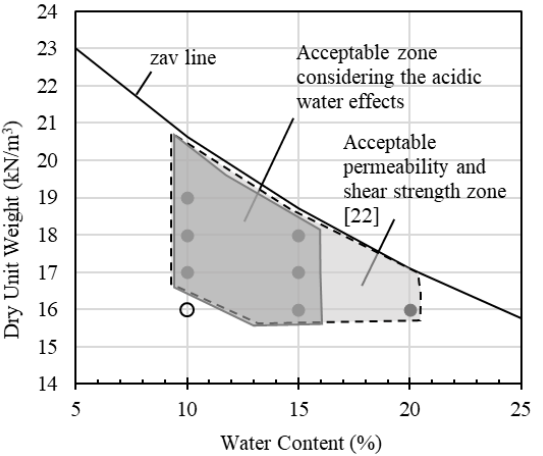
Fig. 9. Acceptable zone of claystone‒bentonite mixture considering acidic water